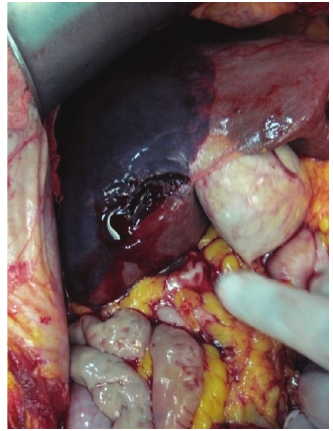
Figure 2: Bleeding hematoma at segment V.